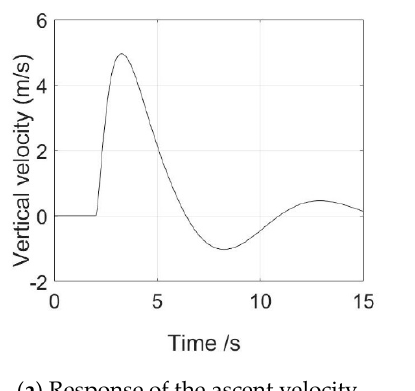
Figure 8. Response curve of ascent velocity and height control.